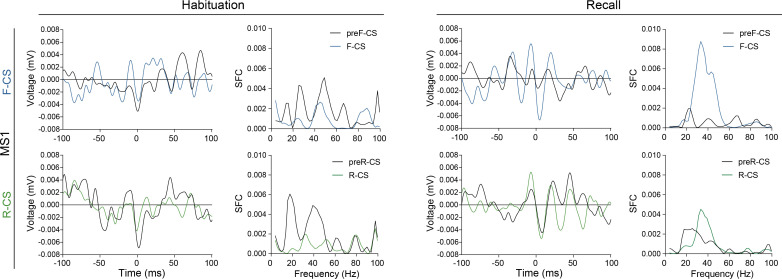
The aIC–pIC hierarchy is valence-asymmetric.Valence-resolved STA of 200 ms pIC LFP traces centered around the occurrence of spikes from aIC and the resulting pIC LFP power-normalized SFC thereof for habituation and recall for animal MS1 (as in Figure 3B).